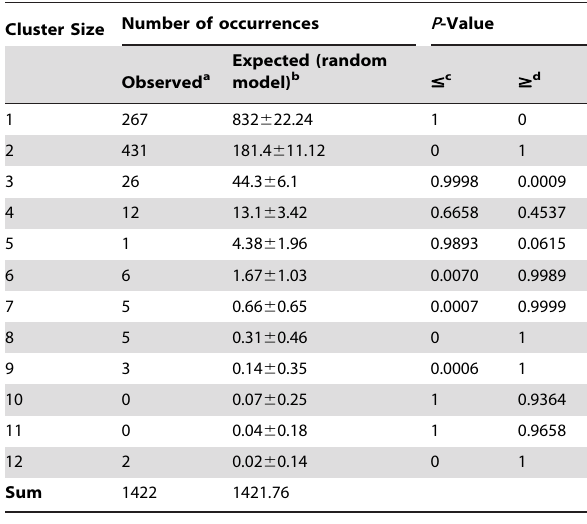
Table 3. Frequency of REP clusters within the SBW25